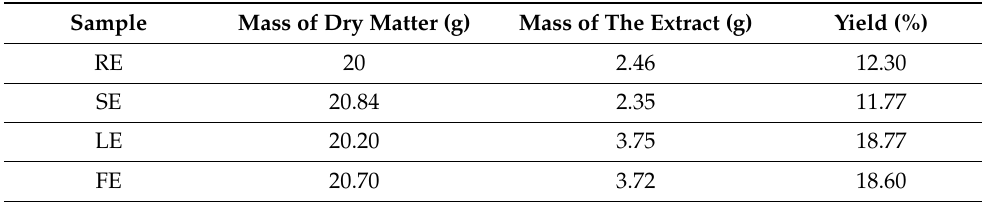
Table 1. Extraction yield of P. rhoeas